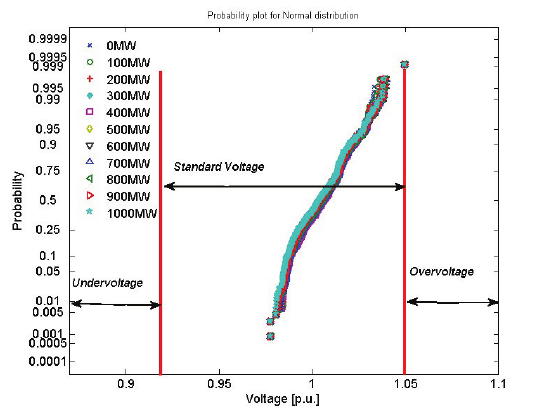
Figure 7. Wind power variability vs. distribution probability of voltage regulation curve in the FirstEnergy/PJM transmission system.